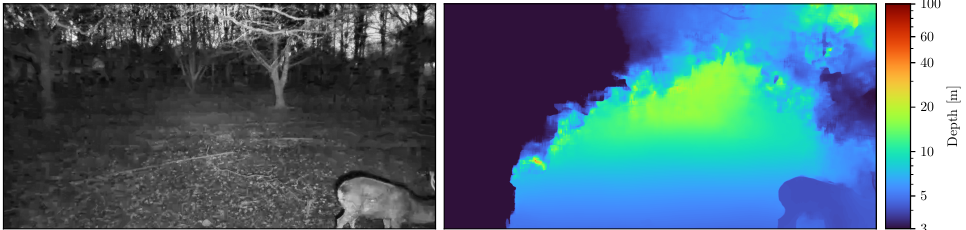
Figure 6. Stereo matching inevitably fails in regions where there is not enough available